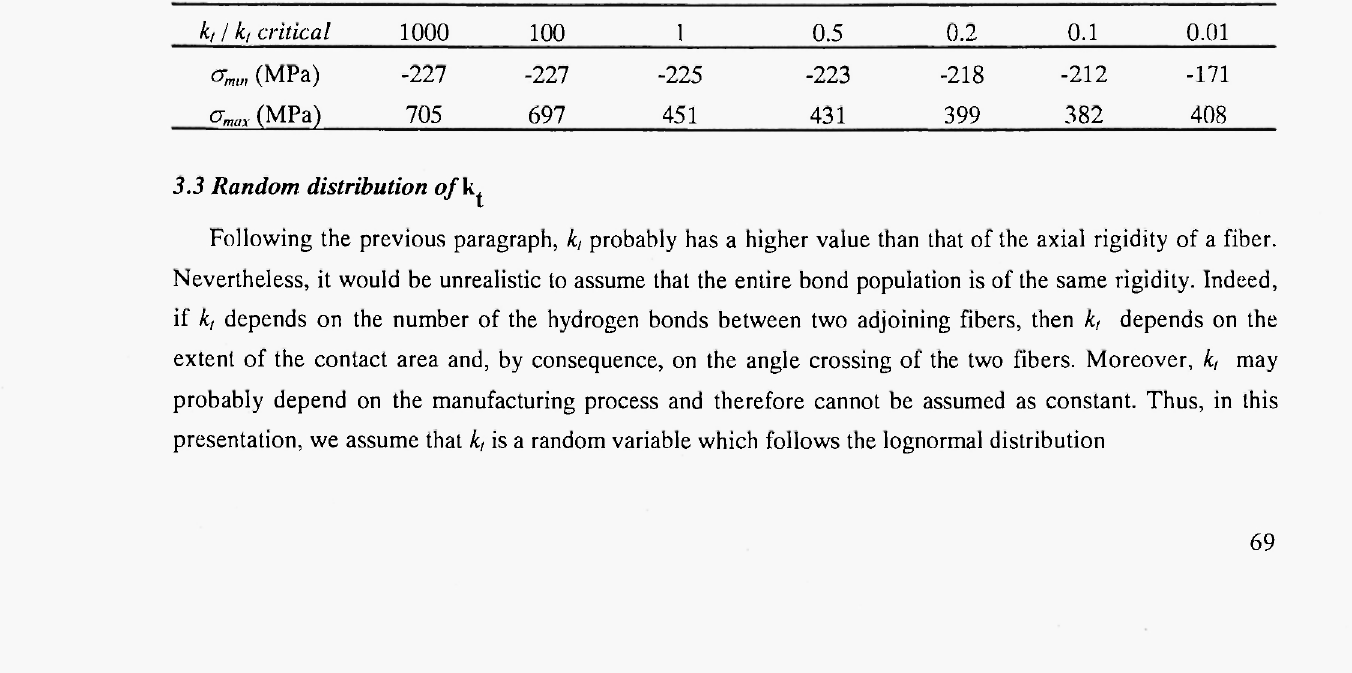
Stress distribution for different